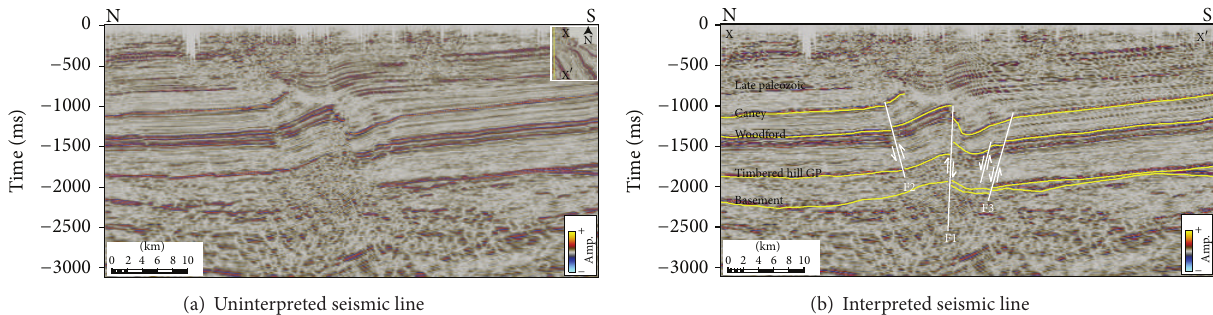
Figure 10: (a) Uninterpreted seismic line XX 󸀠 and (b) interpreted seismic line XX 󸀠 showing an area of intensive deformation where some basement normal faults were reactivated as reverse faults (F1 and